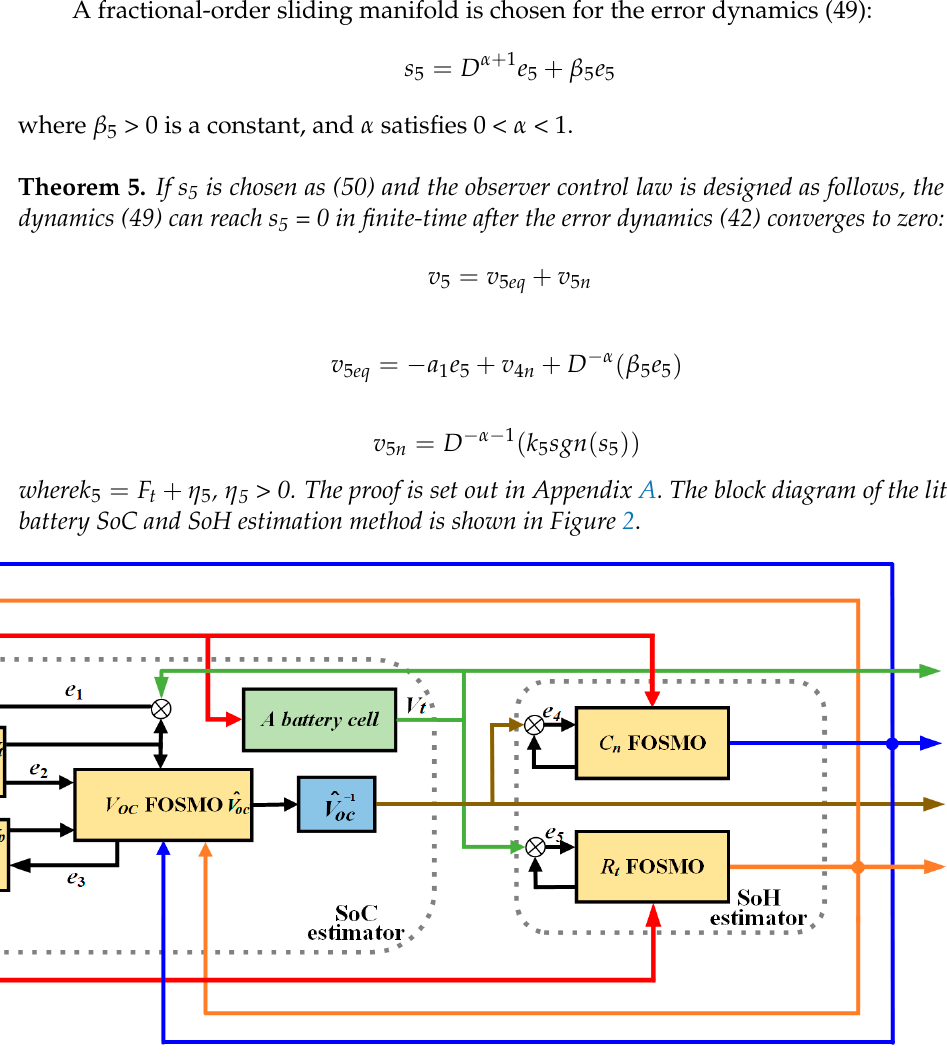
Figure 2. Block diagram of SoC and SoH algorithms.